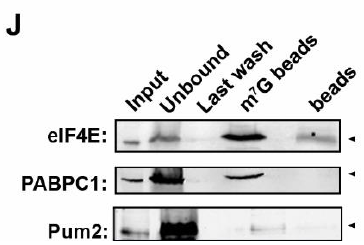
Figure 3. Pum2 promotes eIF4E translation. ( A , B ) RNA ( A ) and protein ( B ) fold changes of growth regulators upon knock-down of Pum2 (data extracted from the work in [18]). ( C ) Consensus sequence and E-value of the 5 (cid:48) -UTR of Pum2 regulated mRNAs identified by MEME analysis. ( D , E ) Representative immunoblot ( D ) against eIF4E and quantifications I upon incubation of mature (14 DIV) cortical neurons with bFGF, NGF, and EGF, respectively, for two days. β -III Tubulin was used as loading control. ( F ) Representative immunoblot against eIF4E from shControl and shPum2 transduced cortical neurons (14 DIV) and quantification normalized to Vinculin and β -III Tubulin. ( G ) Relative eIF4E mRNA levels in shControl and shPum2 transduced neurons. Peptidyl-prolyl cis-trans isomerase A ( PPIA ) was used as reference gene. Line connects control and Pum2 depleted conditions from identical cultures. ( H ) Representative polysome profile (18–50%) of post-nuclear brain lysate and representative immunoblots for Pum2 (eIF4E and PABPC1 served as marker for the translation initiation machinery, Rpl7a for ribosomes). ( I ) Representative immunoblot for Pum2 upon centrifugation through high-resolution sucrose gradients (5–25%). eIF2s1 and eIF4E served as markers for the translation initiation machinery, Rpl7a and Rps6 for large and small ribosomal subunits, respectively, FMRP is a Pum2 protein interactor. ( J ) Representative immunoblot against eIF4E, PAPBC1, and Pum2 upon incubation with m 7 G beads. Arrow heads indicate the respective proteins. p -values were calculated using Wald test ( A ), unpaired Student’s t -test ( B ), and one-sample t -test ( E , F ). * p < 0.05, ** p < 0.01, **** p < 0.0001, 3–4 biological